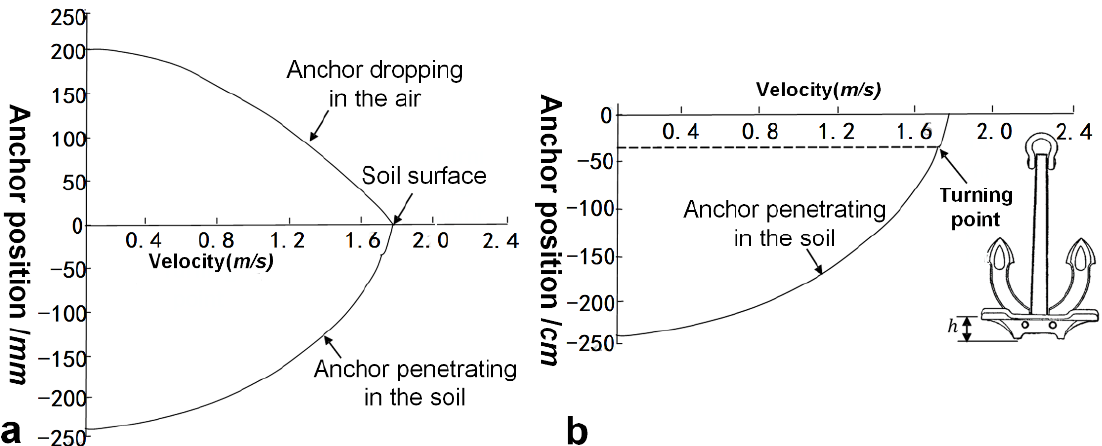
Figure 12. Dropping velocity versus dropping height and penetration depth. ( a ) The anchor dropping in the air and the soil. ( b ) The anchor penetrating in the soil and the turning point.